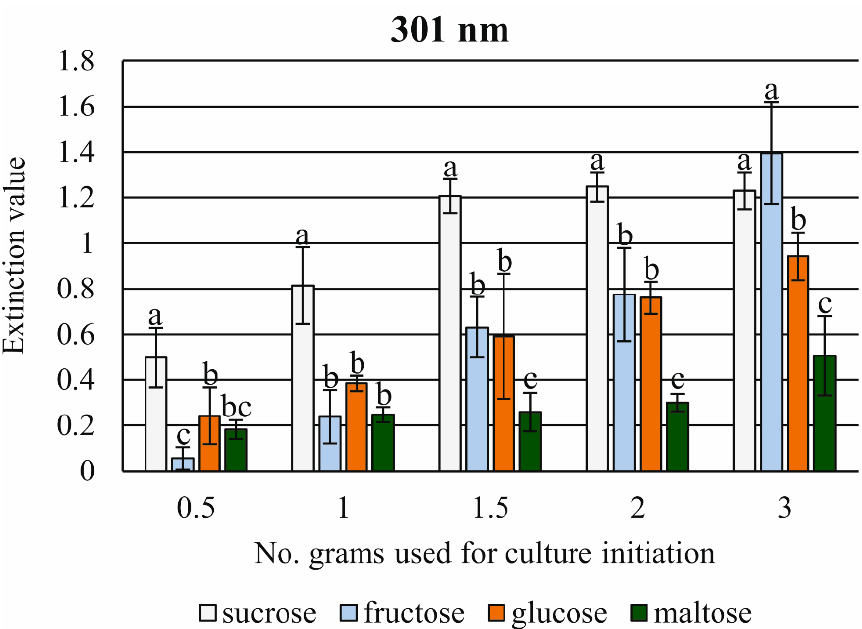
Figure 10. The effect of 20.0 g of saccharides and initial weight of cell suspension tissue on the extinction value of quercetin measured at 301 nm wavelength in the post-culture medium after a two-week-long subculture. Means ± standard deviations marked by different letters are significantly different ( p ≤ 0.05).